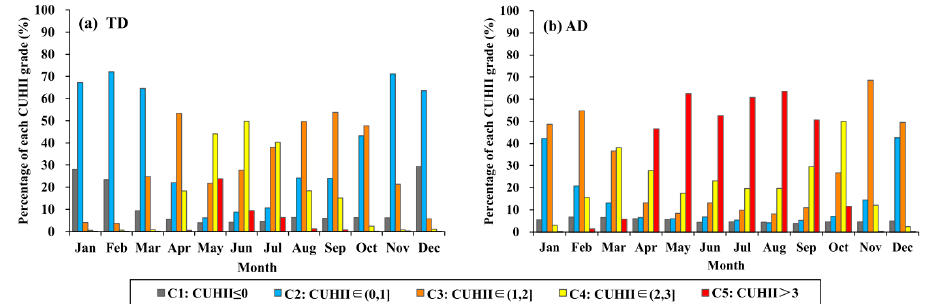
Figure 9. The area percentage of each CUHI intensity grade derived from daytime CUHI Climatological maps for each month at the: ( a ) Terra daytime overpass (TD); and ( b ) Aqua daytime overpass (AD).